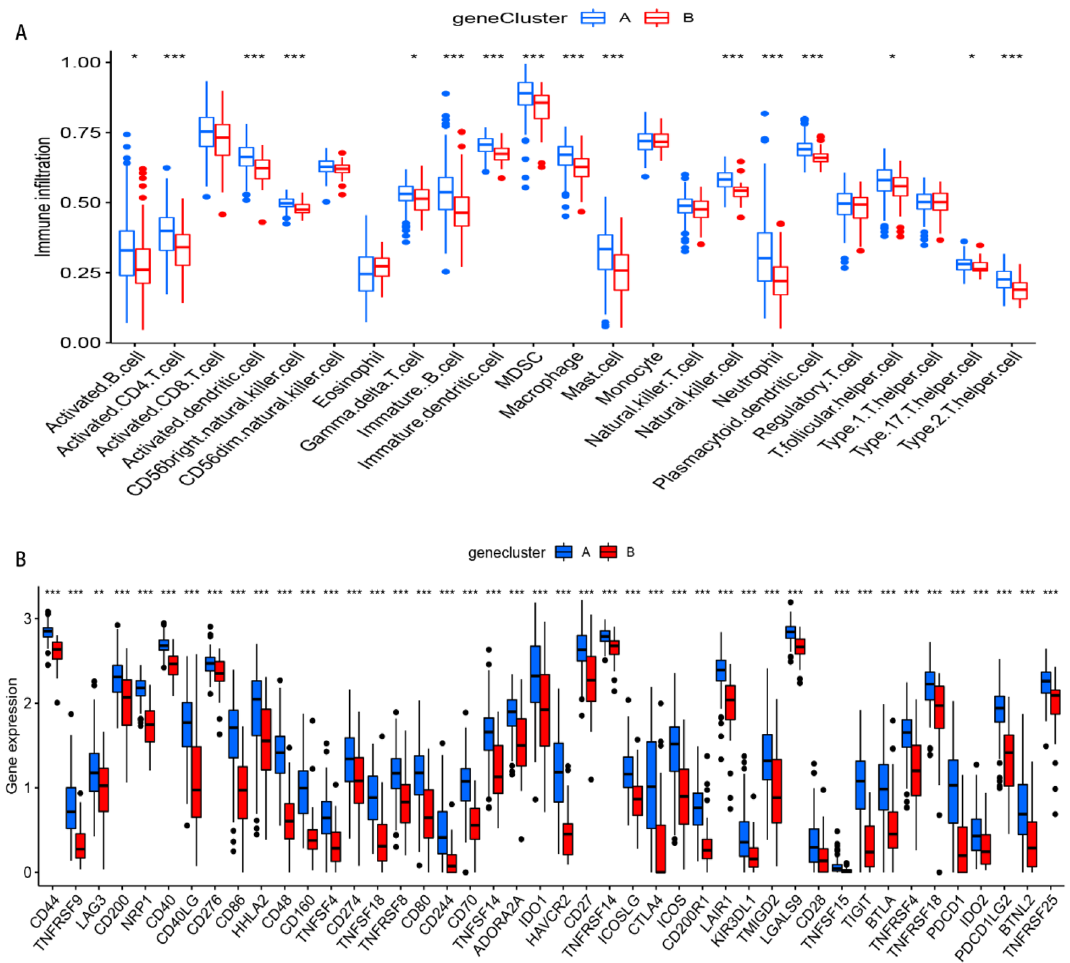
Figure 10. Analyses of immune cells infiltration and immune checkpoints in two m5Cclusters. ( A ) The relationship between immune cells infiltration with two m5C patterns. ( B ) The boxplot of immune checkpoints in the two m5C patterns. * p < 0.05, ** p < 0.01, and *** p <